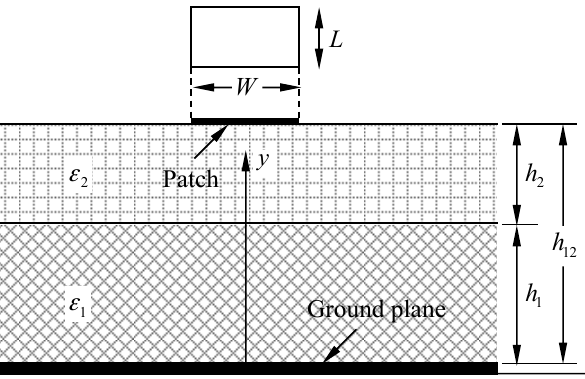
Figure 1. Cross-section of dual-substrate antenna sensor.